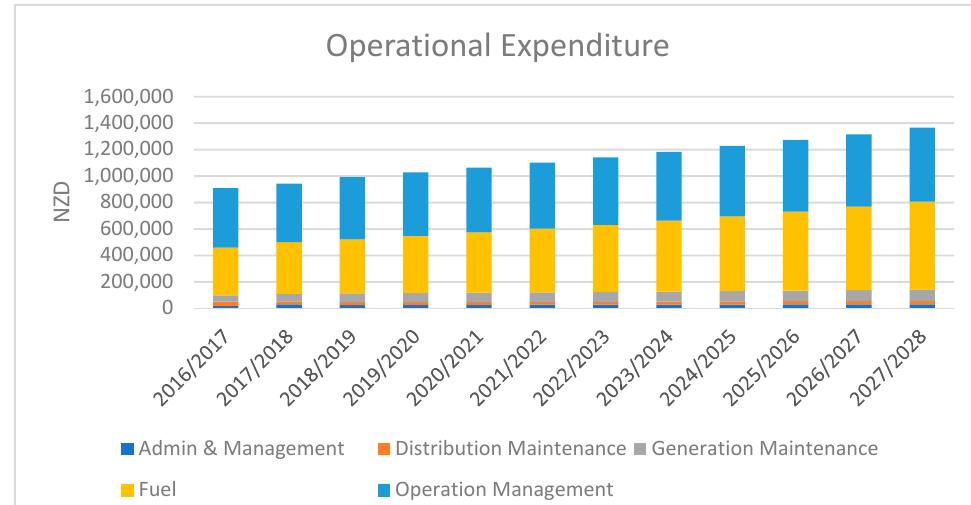
Figure 2. Electricity supply expenditure of Stewart Island [15].